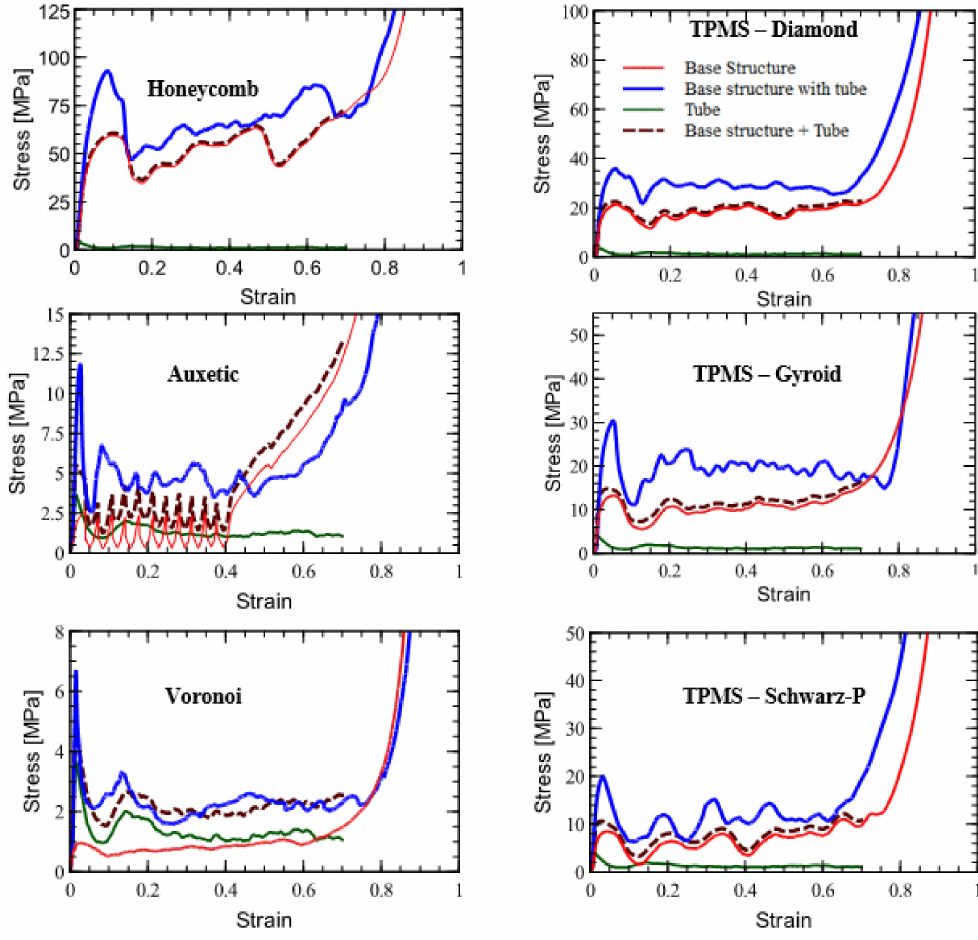
Figure 19. Stress–strain compressive behavior of cellular materials enclosed in tubes, compared to the same designs without a tube. Also shown is the behavior of the tube alone and the curve obtained from numerical addition of the tube and base